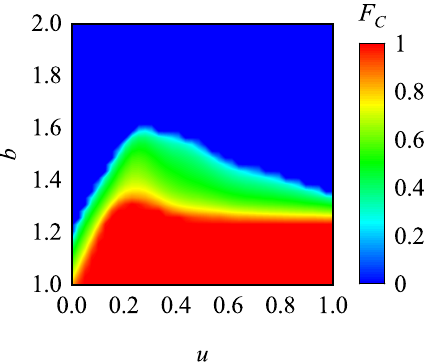
Figure 2. The color map encodes the stationary fraction of cooperators dependent on the temptation to defect T and the punishment factor u . Results obtained with L = 200 and α = 0.5 .